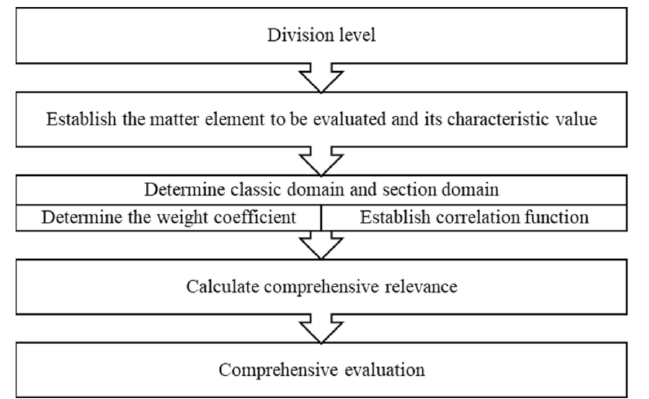
Figure 4. The evaluation process of extension evaluation